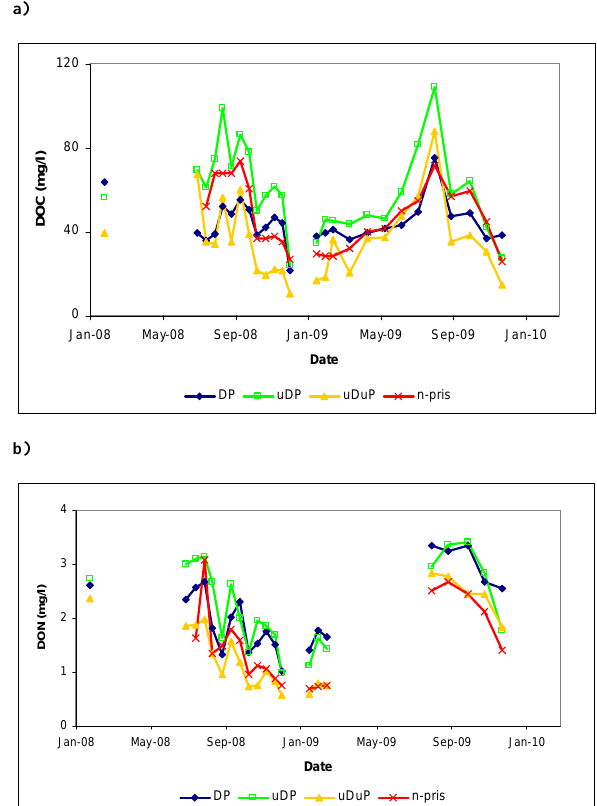
Figure 3. DON and DOC concentrations measured in the dipwell from each treatment Fig. 3. DON and DOC concentrations measured in the dipwell from each treatment at Flanders Moss. Data missing denotes either not at Flanders Moss. Data missing denotes either not measured or not analysed. measured or not